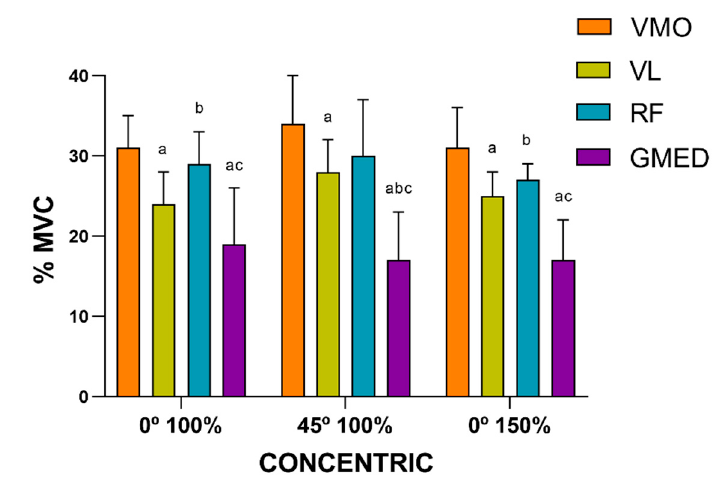
Figure 5. Comparison of the muscle activation (expressed in %MVC) between the muscles during the concentric phase under each condition, performed at the controlled velocity ( ᵃ difference from VM, ᵇ difference from VL, c difference from RF; p < 0.05). VMO: vastus medialis oblique; VL: vastus lateralis; RF: rectus femoris; GMED: gluteus medialis.